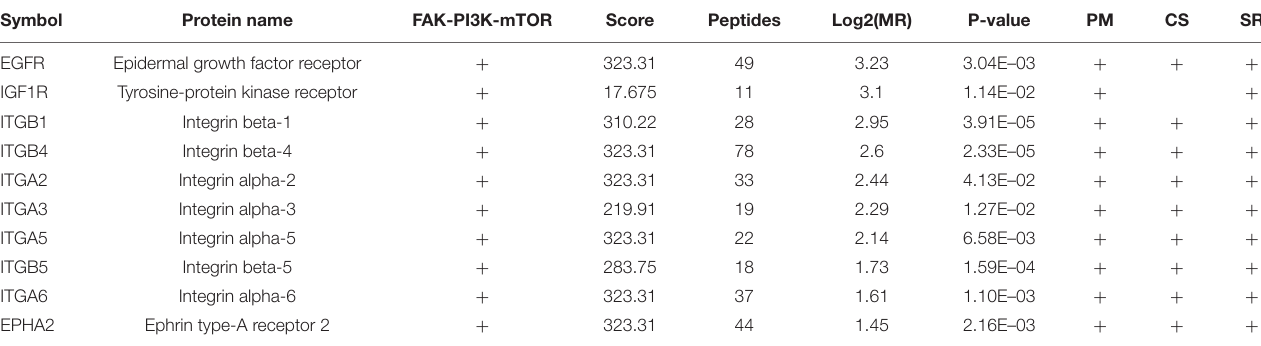
FIGURE 3 | Signaling pathway enrichment analysis and interaction network analysis of DEPs (A) Enriched Wikipathway for differentially expressed surface-exposed proteins in 5-8F cell lines vs. 6-10B cell lines. (B) Overlapping of MYOF-interacting proteins and differentially expressed signaling receptors in 5-8F vs. 6-10B cells. MYOF-interacting proteins were retrieved using Harmonizome. (C) Partial interaction network of differentially expressed proteins focused on the interaction of MYOF, EGFR and EPHA2. (D) The interactions of MYOF with EGFR and EPHA2 were confirmed by Co-IP assay. Co-IP using anti-MYOF and negative control antibodies were performed in 5-8F cells. Western blots for all three proteins were performed. The density of the bands was analyzed by using NIH ImageJ software and normalized by the arbitrary units of the band of the input of EphA2. Data are the means ± SDs of 3 experiments. ** p < 0.05 and ** p < 0.01. TABLE 3 | Dysregulated signaling receptors in 5-8F vs. 6-10B